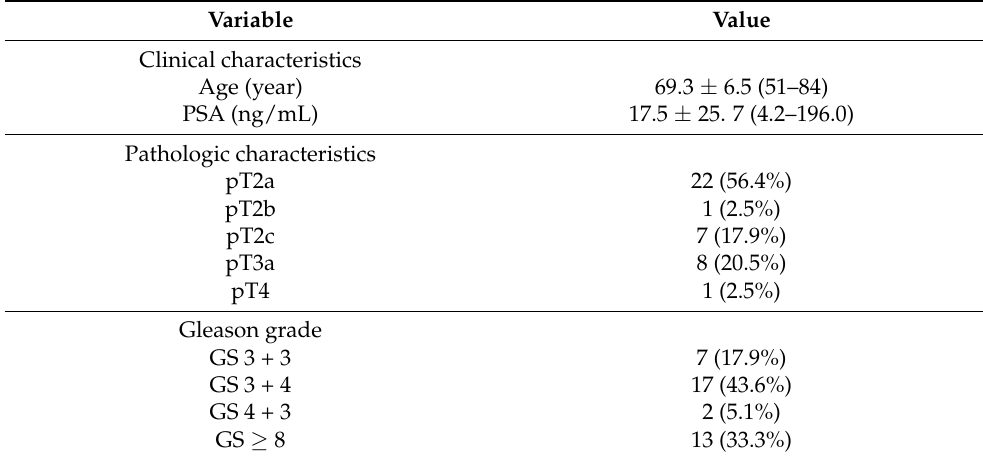
Table 1. Summary of clinical and pathologic characteristics. For clinical characteristics, data are means and standard deviations with ranges in parentheses. For pathologic characteristics, data are numbers of patients with percentages in parentheses. For Gleason grade, data are numbers of tumor foci, with percentages in